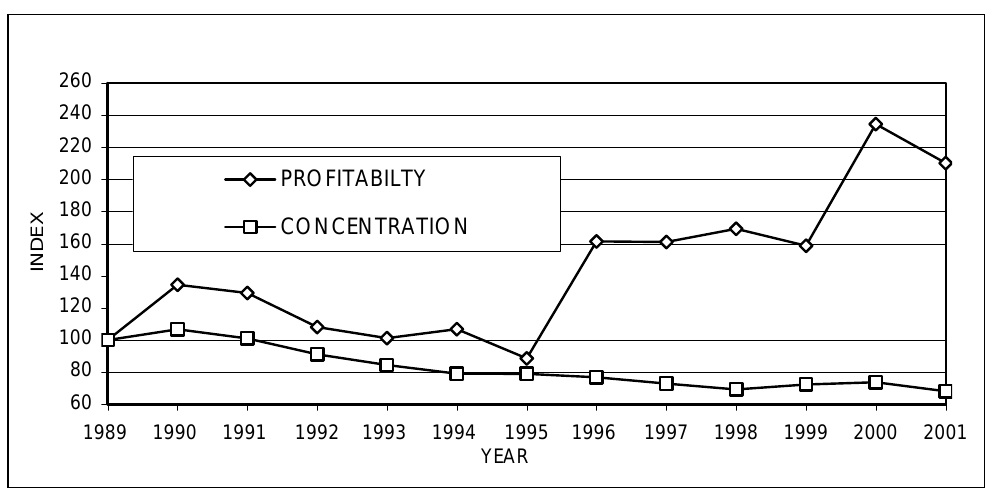
Profitability and concentration index, 1989-2001